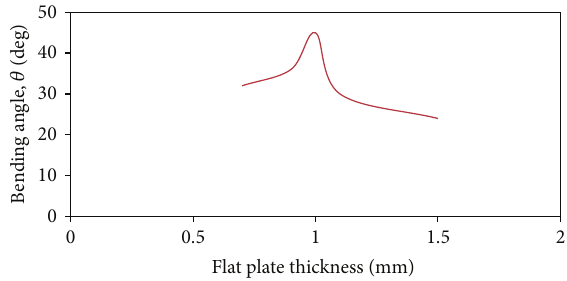
Figure 7: Variation of bending angle for different flat plate thickness ( 𝐴 ) of actuator.